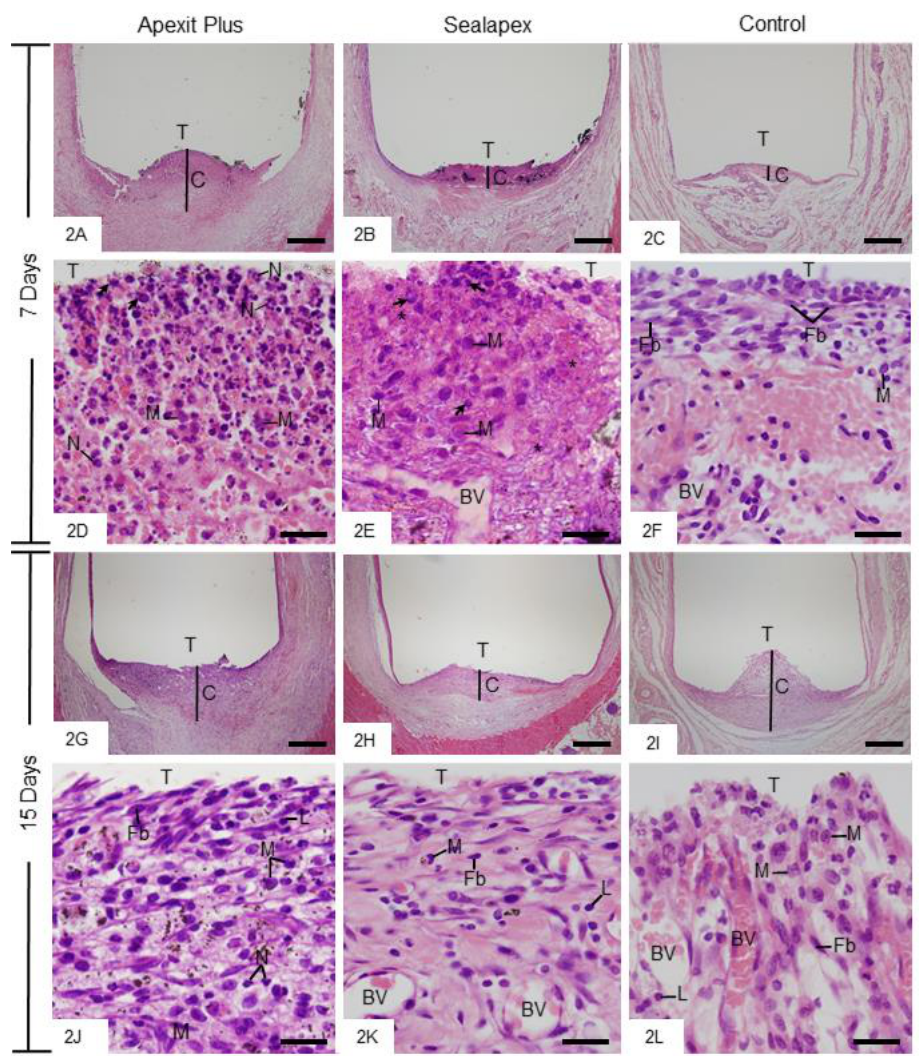
Figure 2. Photomicrographs show portions of capsules (C) surrounding the opening of